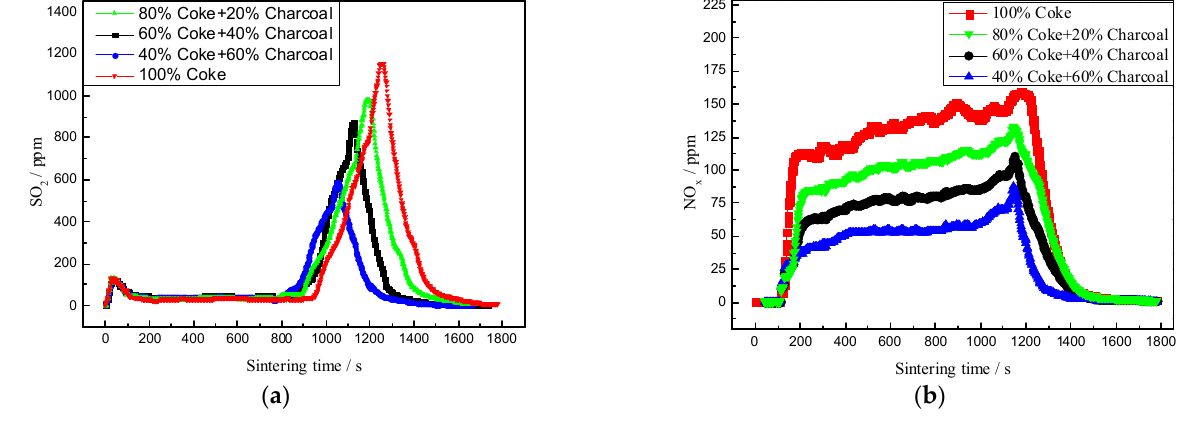
Figure 4. Effects of charcoal on the SO 2 and NO x content in flue gas. ( a ) SO2 emission curve; ( b ) NO x emission curve.